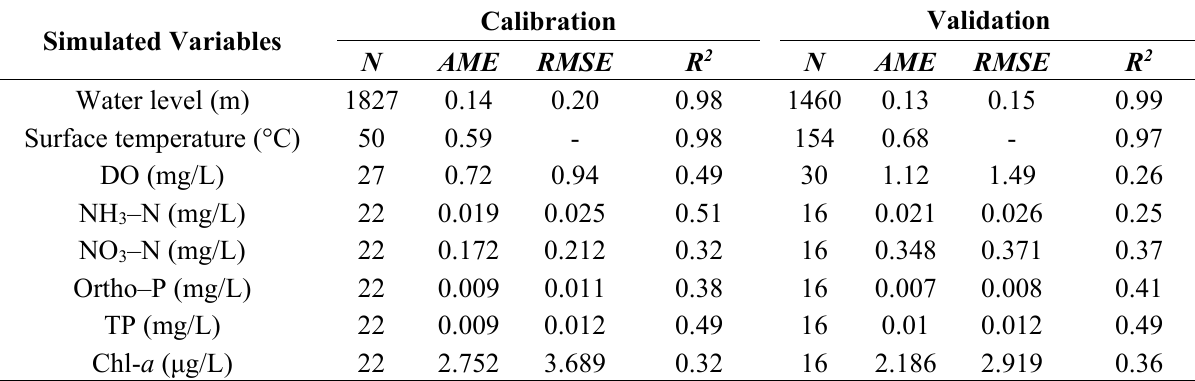
Figure 4. The calibration and validation results of W2 simulated hydrodynamic parameters at surface layer of segment 3. Sub-figures show the comparisons between W2 simulation results to: measured water level during ( a ) calibration and ( b ) validation periods; and measured water temperature during ( c ) calibration and ( d ) validation periods. Table 3. Summary of the performance indicators for the W2 modeling of hydrodynamic and water quality variables during calibration and validation